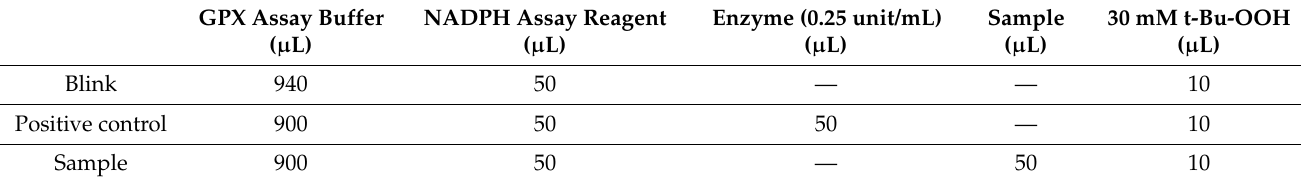
Table 1. Glutathione peroxidase activity reaction